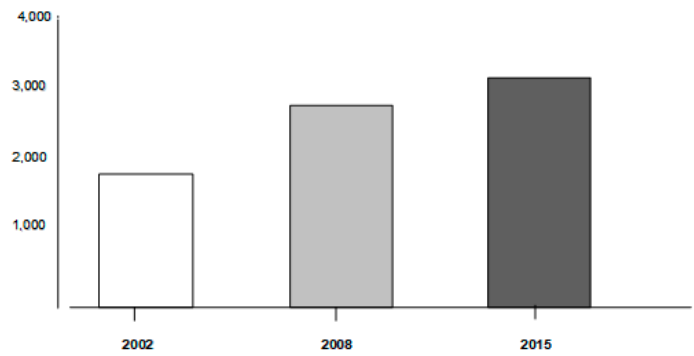
Figure 1. The trend of the annual chronic obstructive pulmonary disease (COPD) cost-of-illness from 2002 to 2015 in Italy.